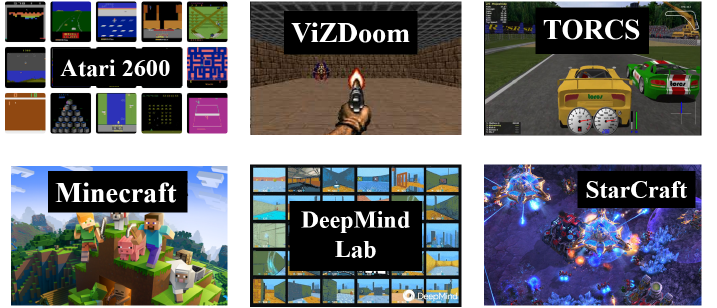
Figure 5. Popular video-game platforms for Reinforcement Learning research, summarized from [59].